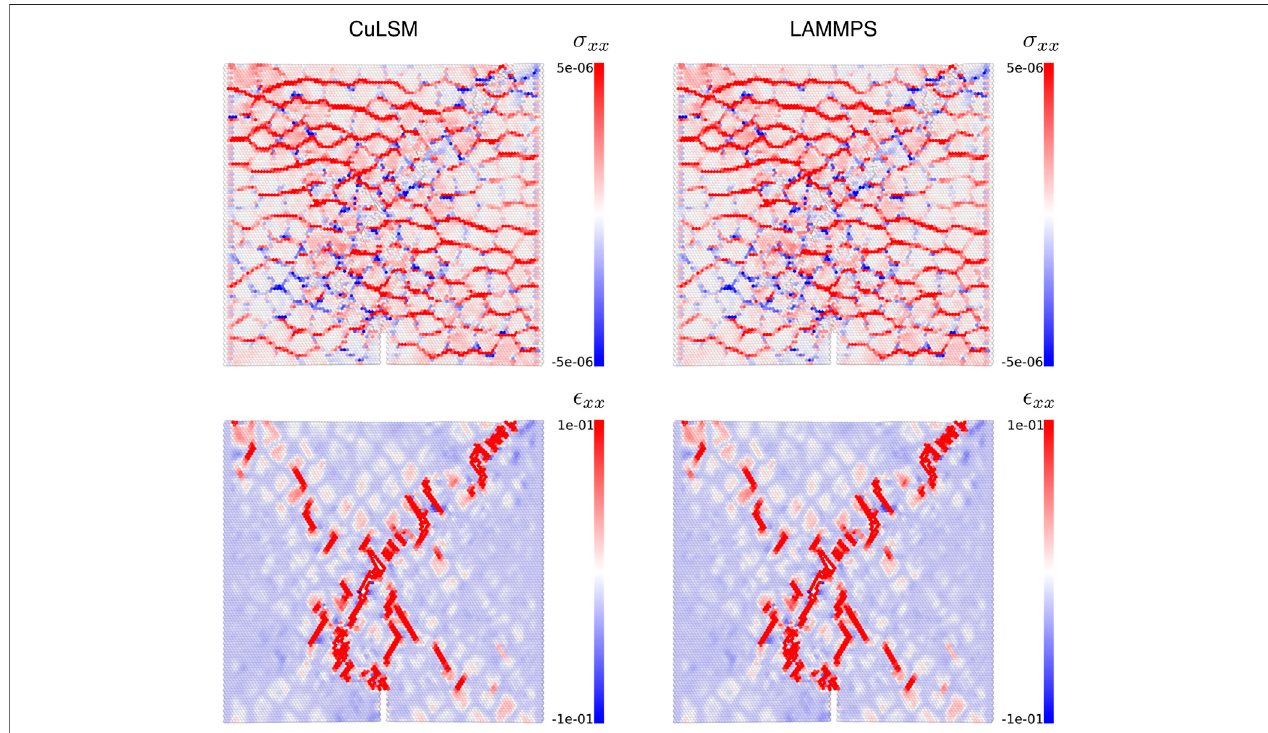
FIGURE 6 | Stress and strain fi elds in Poisson composites calculated by CuLSM and LAMMPS at engineering strain ϵ (cid:2) 0.02.